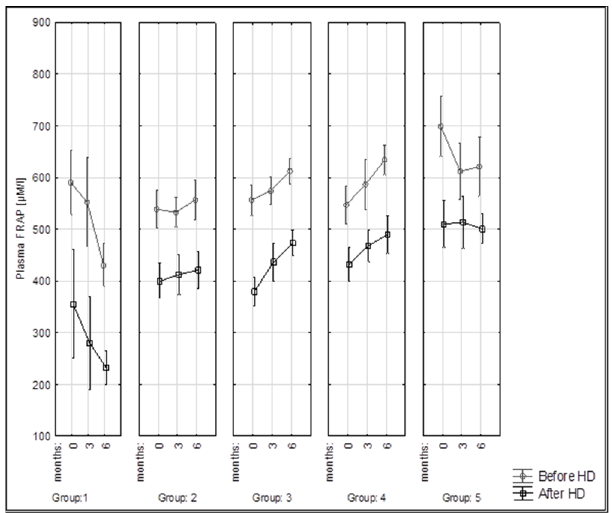
Figure 4. Changes in FRAP activity ( µ M/L) in examined groups of patients during 6 months of the study.